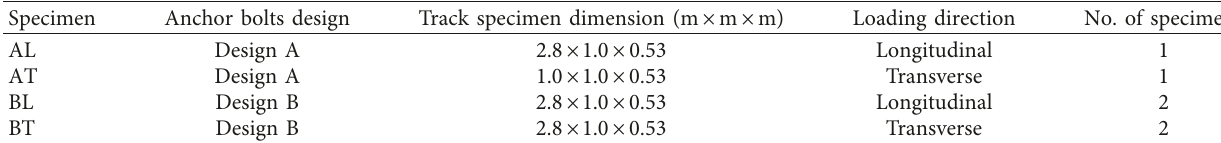
Table 5: Test variables and the specimen